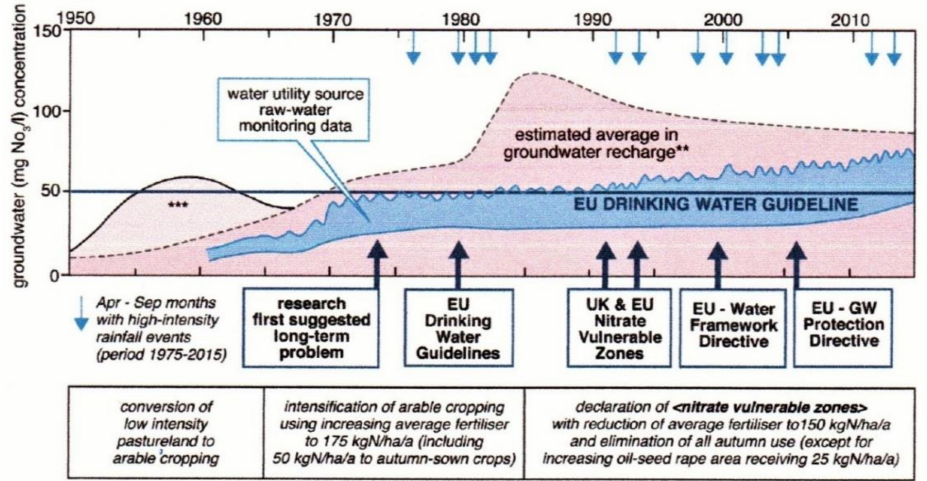
Figure 1. Evolution of land-use, groundwater nitrate and management measures in the East Yorkshire Chalk, United Kingdom. (** using (a) estimates of cropped area from 1980 as winter-wheat 45%, winter-barley 15%, oil-seed rape 15%, spring-barley 15% and uncropped land 15%. (b) Fertiliser N usage survey data distinguishing readily leached autumn dressings from spring dressings only leached by very exceptional rainfall events. *** very approximate estimate of leaching following initial ploughing-in of pasture